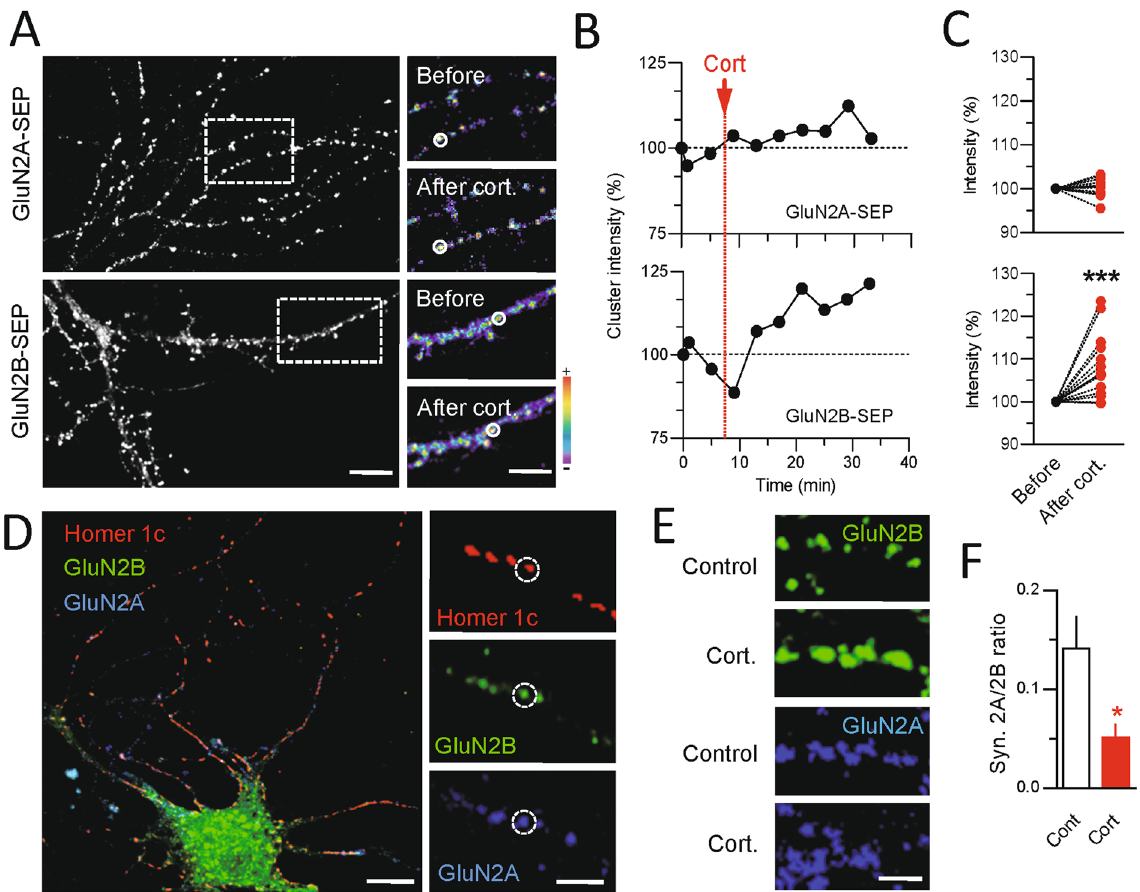
Figure 1. Corticosterone alters surface GluN2B-NMDAR clustering. ( A ) Dendritic fragments of GluN2A- and GluN2B-SEP expressing neurons before and after exposure to corticosterone (100 nM). Scale bar = 5 µ m, scale bar inset = 1 µ m. ( B ) Example of fluorescence intensity of GluN2A- (n = 12 dendritic fields, N = 5 neurons) and GluN2B-SEP (n = 15 dendritic fields, N = 5 neurons) clusters over time. ( C ) Comparison of GluN2A- and GluN2B-SEP cluster fluorescence intensity before and after exposure to corticosterone. *** p < 0.001, paired Student t-test. ( D ) Live immunostaining of GluN2A and GluN2B subunits in Homer 1c-DsRed expressing neurons. Scale bar = 10 µ m, scale bar inset = 5 µ m. ( E ) Immunostaining of surface GluN2A and GluN2B subunits before and after exposure to corticosterone. Scale bar = 5 µ m. ( F ) Comparison of the fluorescence intensity of GluN2A (n = 12 dendritic fields, N = 5 neurons) and GluN2B (n = 11 dendritic fields, N = 5 neurons) subunit clusters (expressed as ratio) -SEP before and after exposure to corticosterone (50 nM, 20 min). * p < 0.05, Student